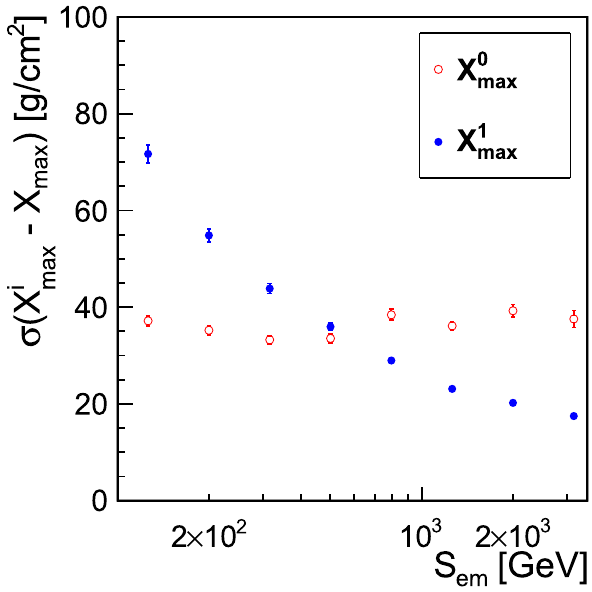
Fig. 9 Resolutionof the X max estimators X 0 max and X 1 max as a function of S em (see text for the simulation details)